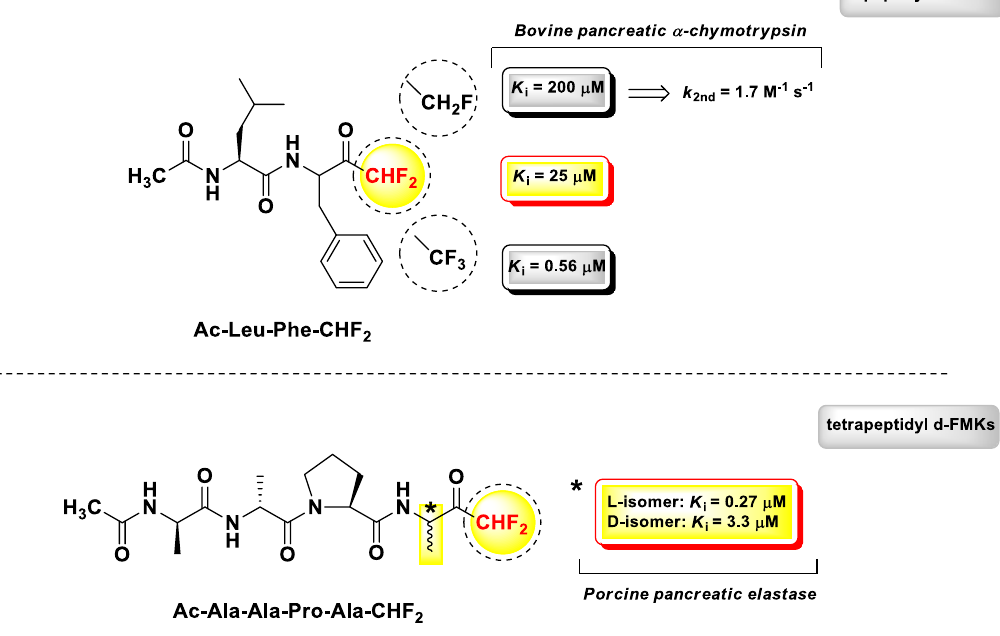
Figure 11. Chemical structures, biological activity, and comparative analysis of most relevant d-PFMKs developed by Imperiali B. and Abeles R.H.